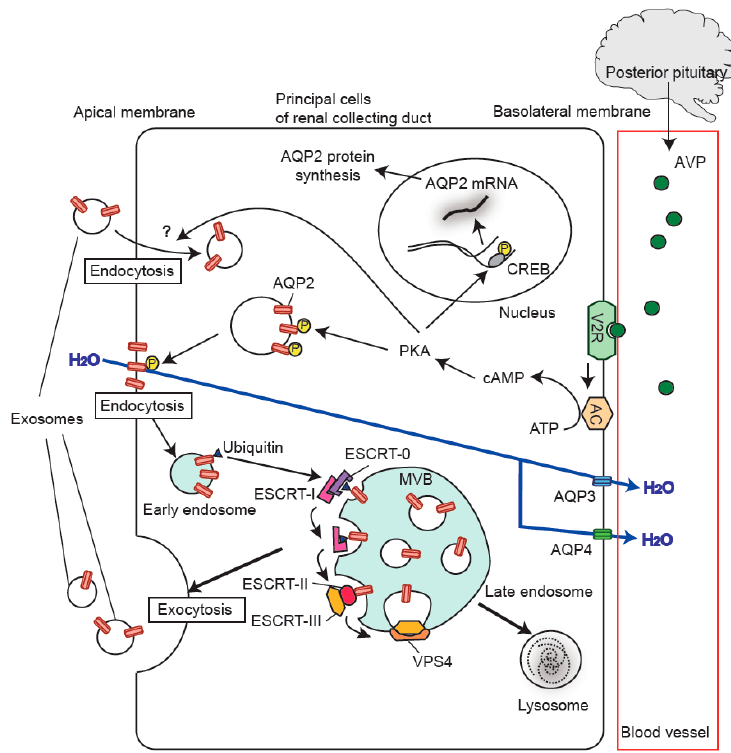
Figure 1. An illustration of the genesis of exosomal aquaporin-2 (AQP2) in renal collecting duct principal cells. Activation of the V2 receptor (V2R) by vasopressin (AVP) released from the posterior pituitary stimulates adenylate cyclase (AC), resulting in an increase of cAMP, thereby activating protein kinase A (PKA). This protein kinase phosphorylates AQP2, thus increasing the expression of AQP2 in the apical membrane through a vesicular trafficking mechanism. The PKA also phosphorylates CRE binding protein (CREB), and this phosphorylated protein enhances transcription of the AQP2 gene, leading to an increase in the synthesis of AQP2 protein. When apical AQP2 is ubiquitinated, the ubiquitinated AQP2 is endocytosed. Endosomal sorting complex required for transport (ESCRT)-0 then captures the ubiquitinated AQP2, and this interaction activates the sequential reactions mediated by ESCRT-I, ESCRT-II, and ESCRT-III. Finally, the endosomal membrane is excised from the endosome membrane through the action of ESCRT III and vacuolar protein sorting 4 (VPS4), thus generating multivesicular bodies (MVBs) including intraluminal vesicles. Once the MVBs fuse with the plasma membrane, the intraluminal vesicles are released as exosomes into the extracellular space. A recent paper has also suggested that an endocytotic pathway for exosomes is stimulated by activation of the V2 receptor in renal collecting duct principal cells [16].